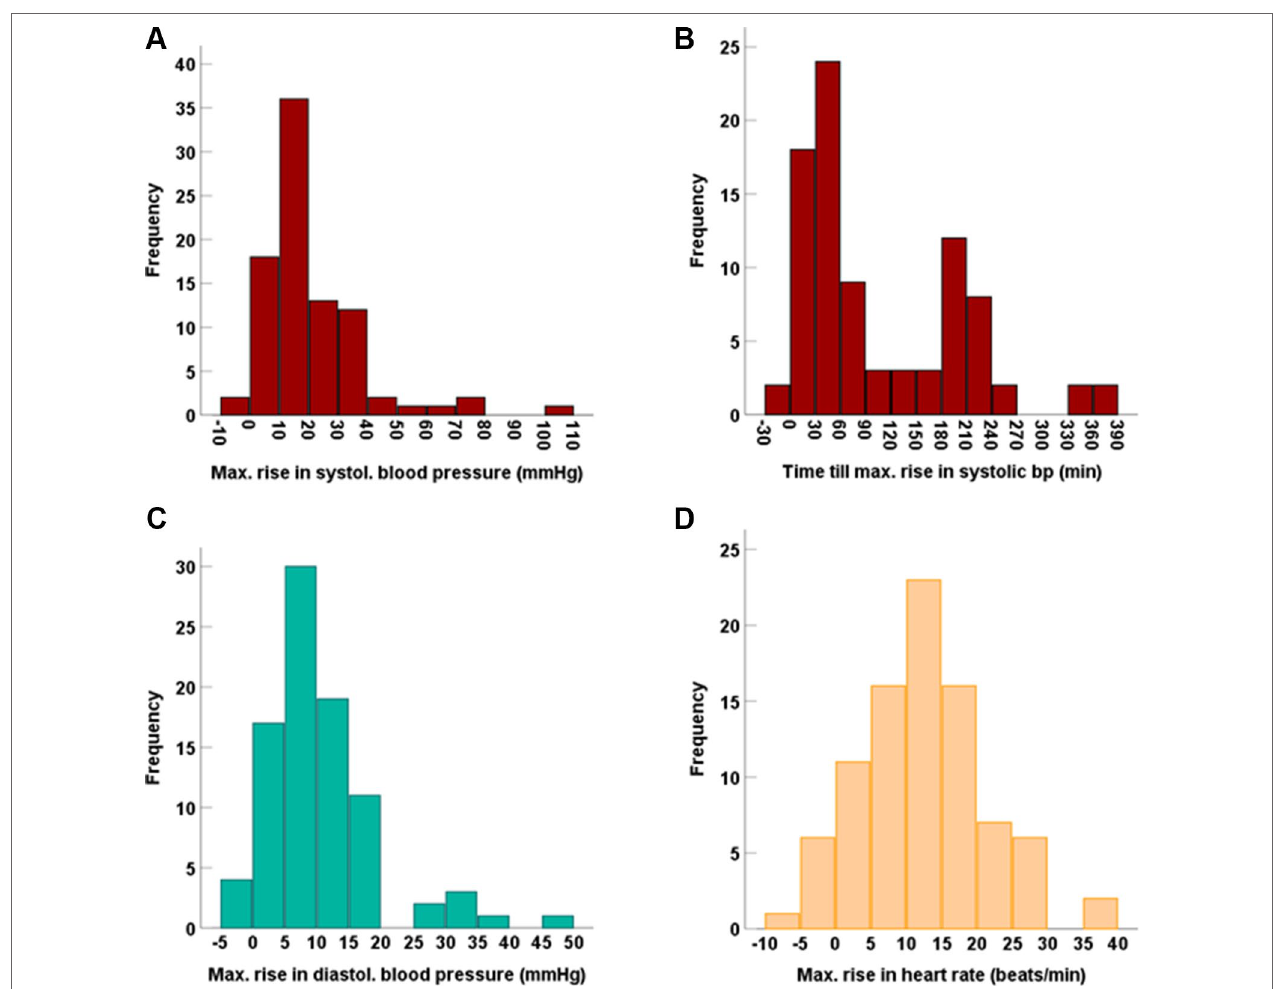
FigUre 7 | Frequency distribution of the maximum increases in (A) systolic blood pressure and (B) the time till this was reached, as well as of the maximum increases in (C) diastolic blood pressure and (D) heart rate.